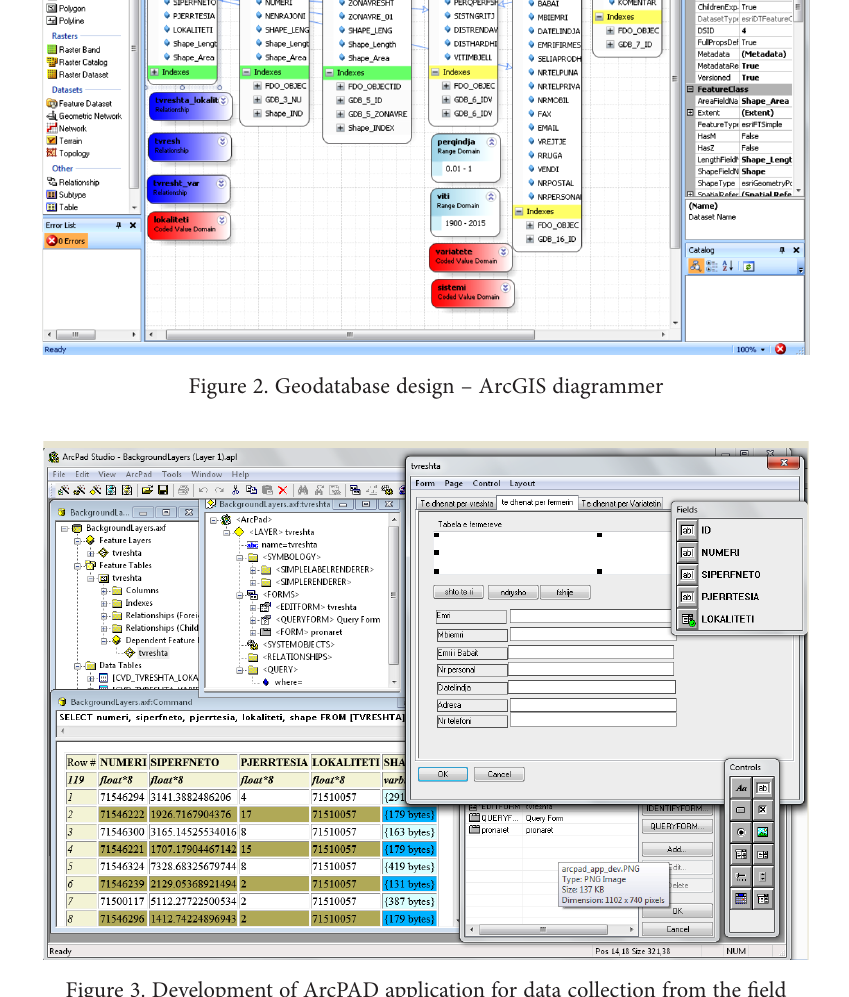
Figure 3. Development of ArcPAD application for data collection from the